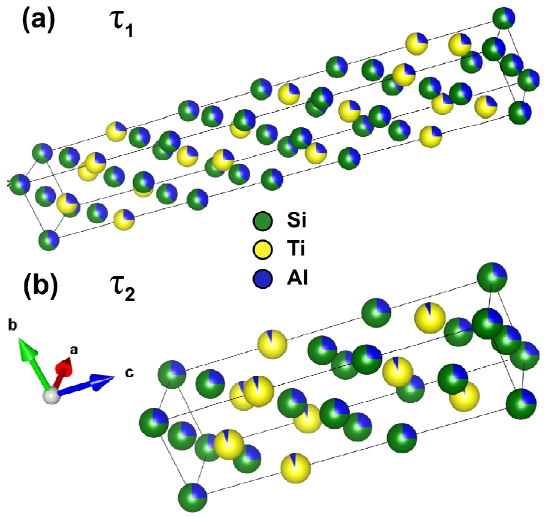
Figure 8. Unit cells of the ( a ) τ 1 and ( b ) τ 2 phase. The τ 1 phase is adapted from its prototype Zr 3 Al 4 Si 5 . Coloring of individual atoms represent relative occupancies according to the CIFs (crystallographic information files). Visualizations were prepared using the VESTA software [41].